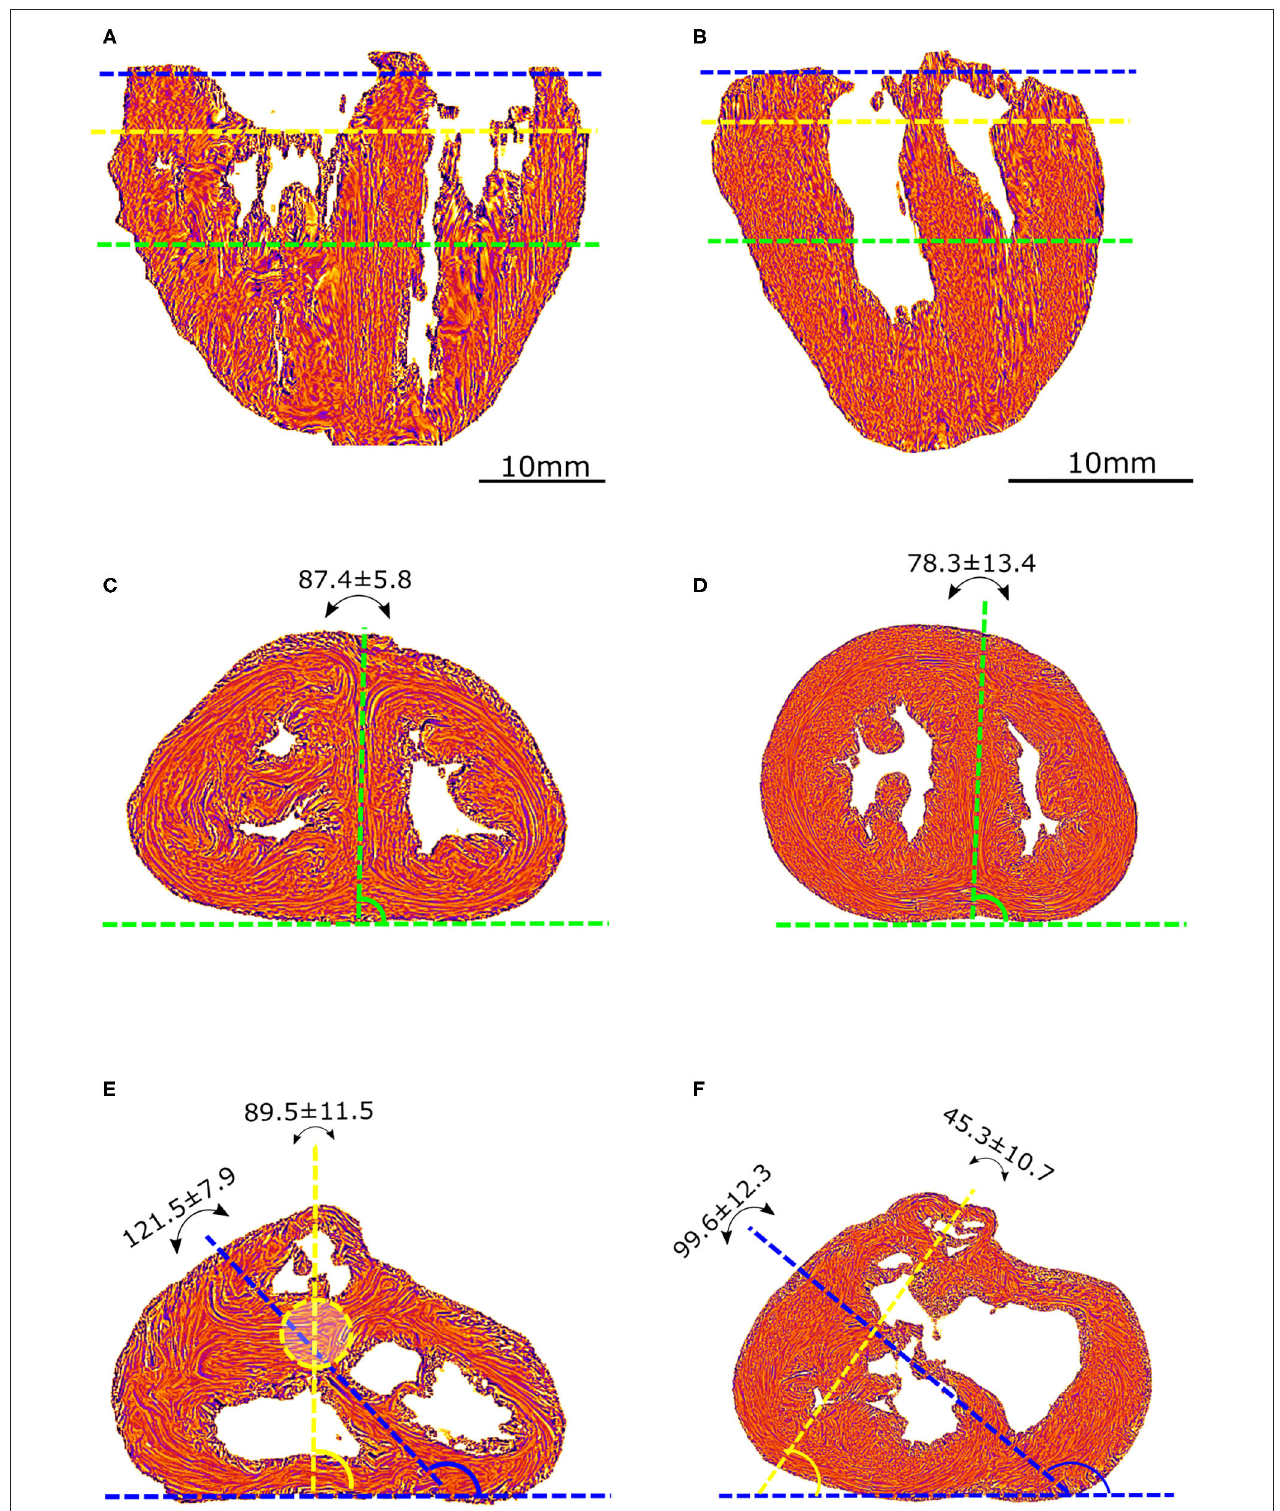
FIGURE 2 | Morphometric measurements: left column-control, right column-ToF. (A,B) Long axis view, the three dotted lines show the different levels along the ventricular mass that are imaged in (C–F) : equatorial (green), aortic (yellow), and pulmonary valves (blue). (C,D) Short axis view equatorial level: IVS-eq angle